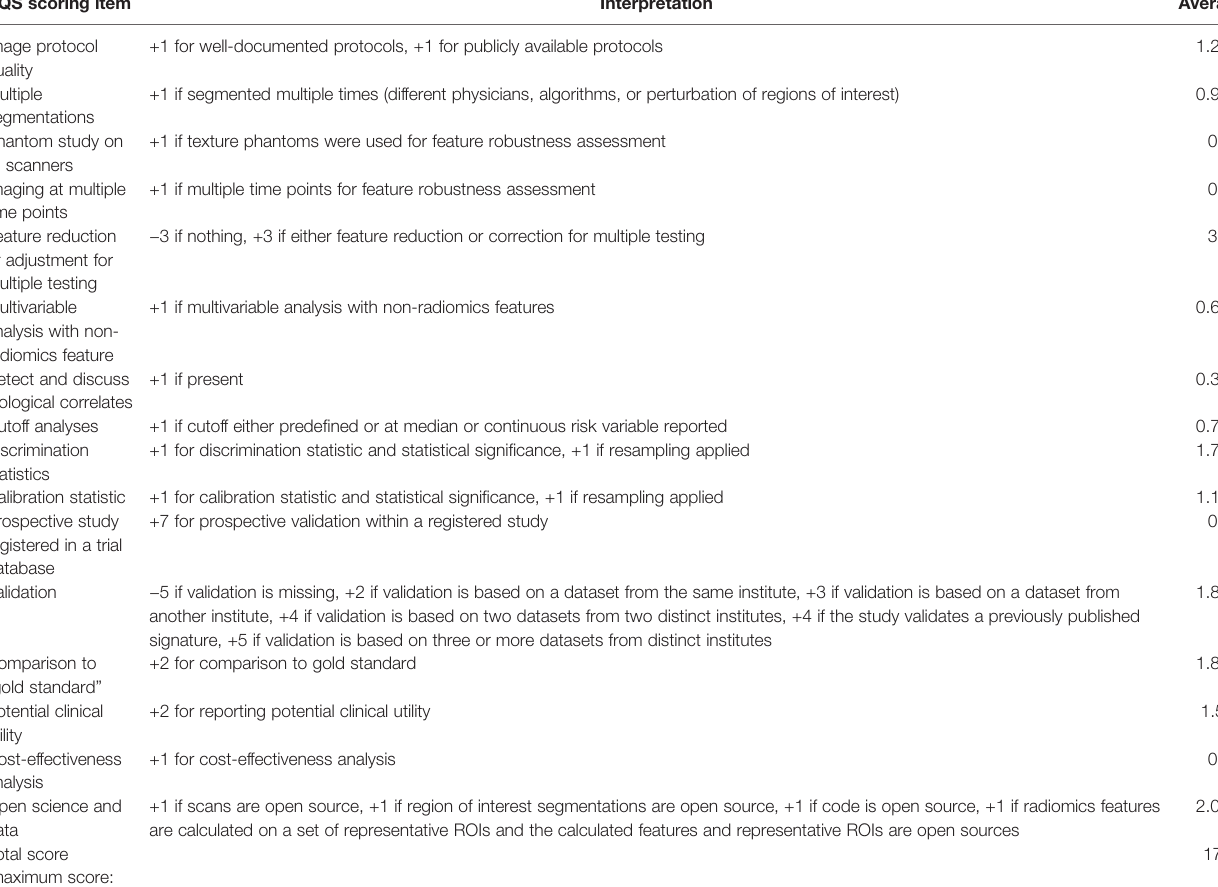
TABLE 2 | RQS elements, as reported by Lambin et al. (28), and the mean rating of our eligible